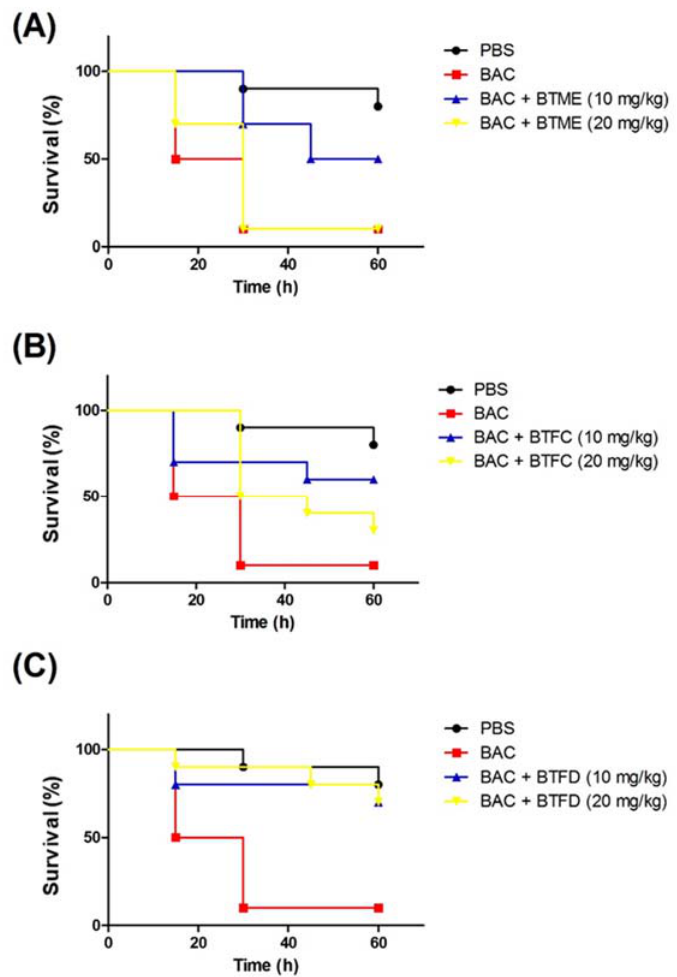
Figure 4. E ff ects of methanolic extract of Buchenavia tetraphylla leaves (BTME) and its fractions (BTFC and BTFD) on the survival of Tenebrio molitor larvae challenged with heat-killed Escherichia coli OP50. ( A ) E ff ects of BTME on the survival of T. molitor larvae challenged with heat-killed E. coli OP50; ( B ) e ff ects of BTFC on the survival of T. molitor larvae challenged with heat-killed E. coli OP50; ( C ) e ff ects of BTFD on the survival of T. molitor larvae challenged with heat-killed E. coli OP50. The larvae ( n = 10 / group) were pre-treated with each sample (at 10 mg / kg or 20 mg / kg) 12 h prior to inoculation of heat-killed bacteria. Larvae treated with phosphate-saline bu ff er (PBS) or E. coli OP50 (BAC) were used as negative or positive controls, respectively. In this set of assays, larvae survival was recorded each 12 h. The experiment was repeated three times.